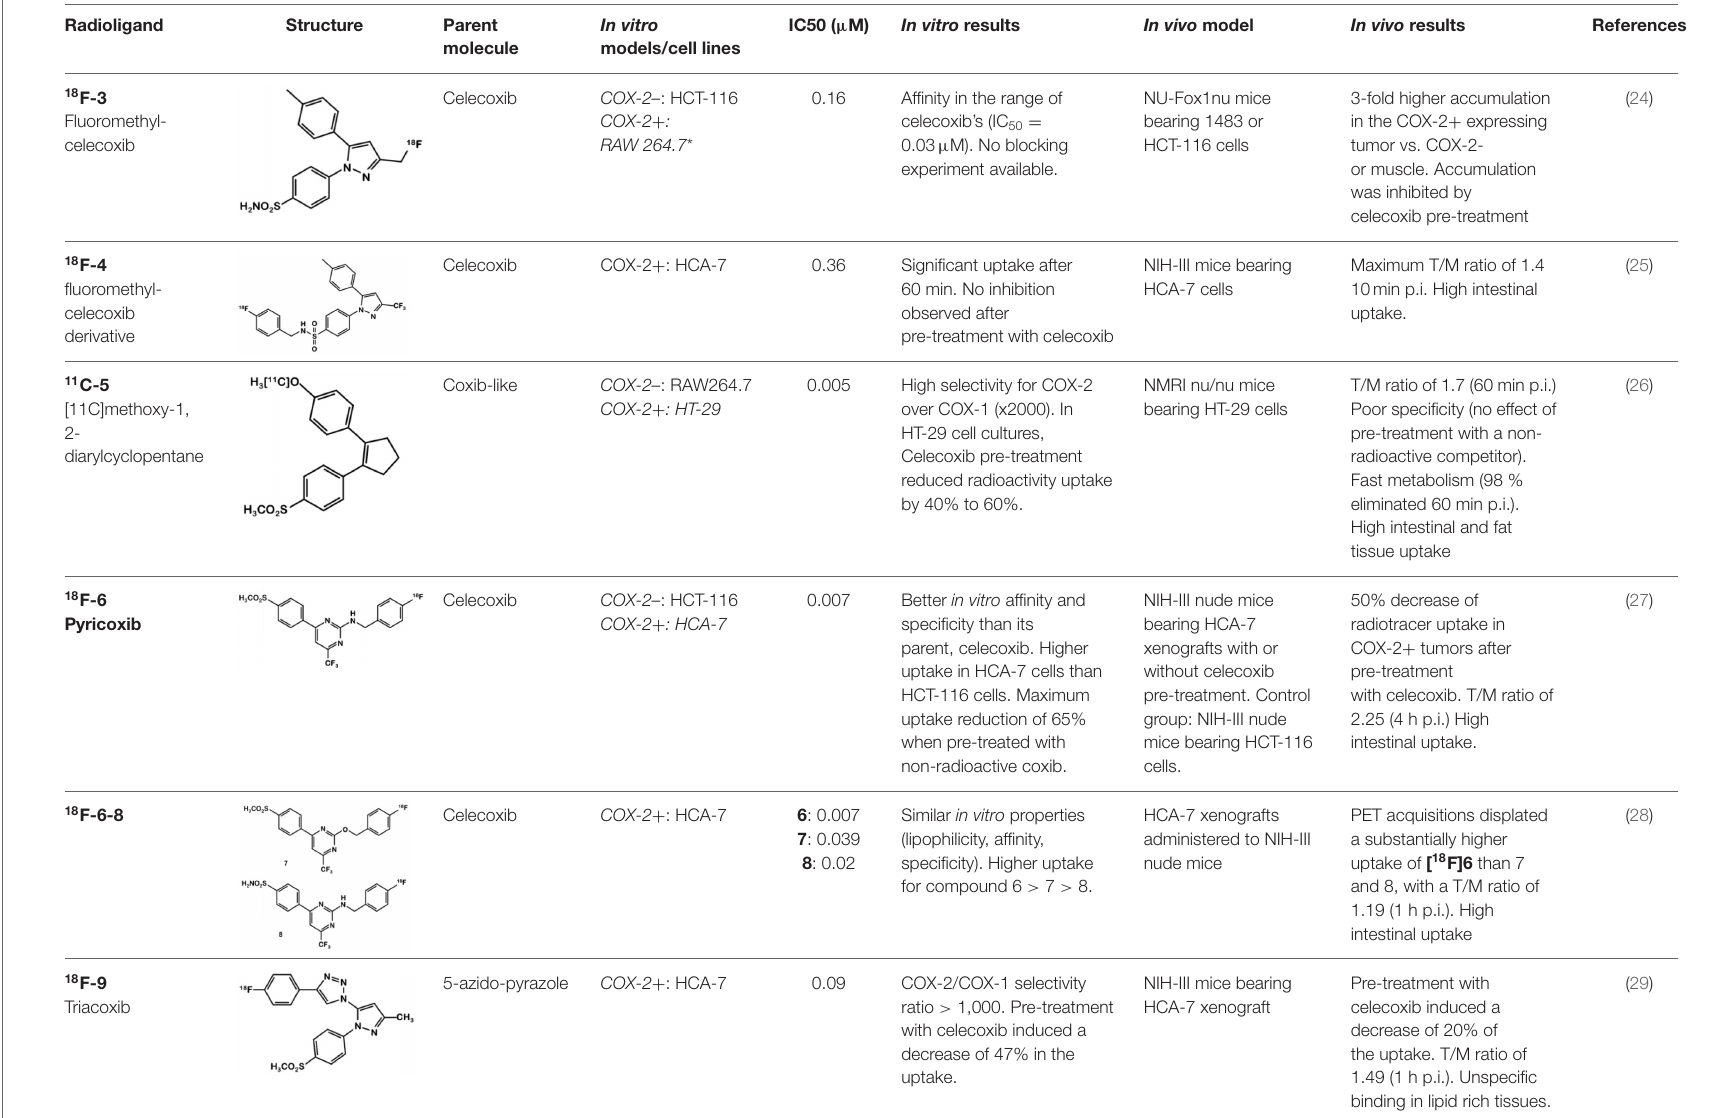
TABLE 1 | Summary of characterization studies assessing COX-2 PET radiotracers in CRC xenograft